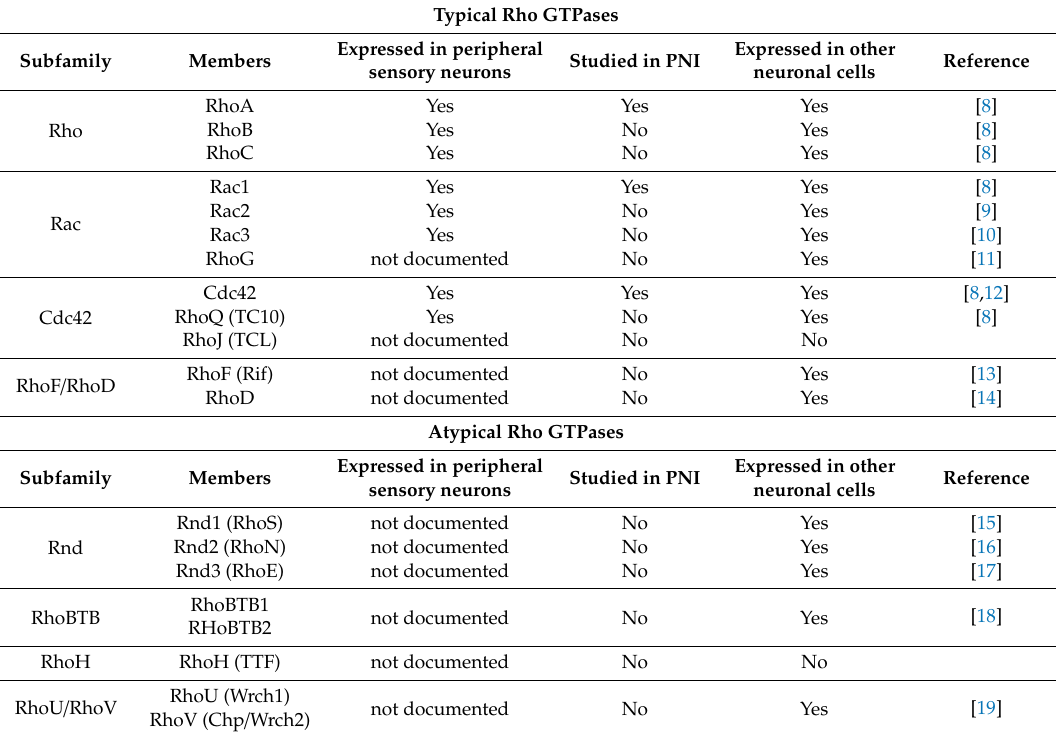
Table 1. The family of Rho GTPases, their members and expression in peripheral sensory